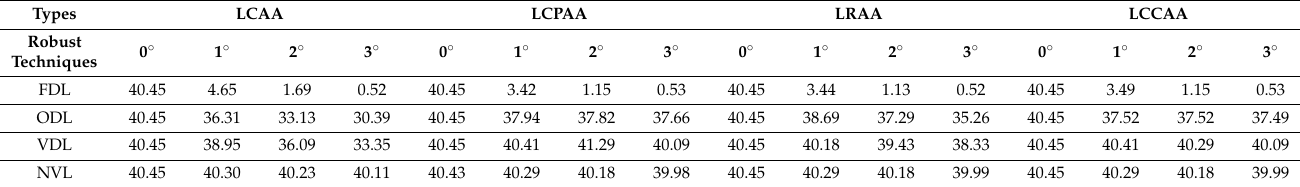
Table 1. SINR comparison using robust techniques with